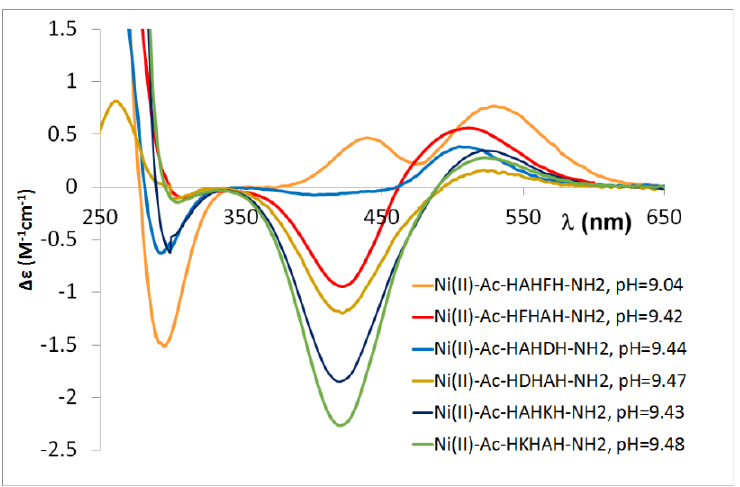
Figure 12. CD spectra registered in equimolar solution of Ni(II)-multihistidine pentapeptide systems at pH 9.0–9.5.